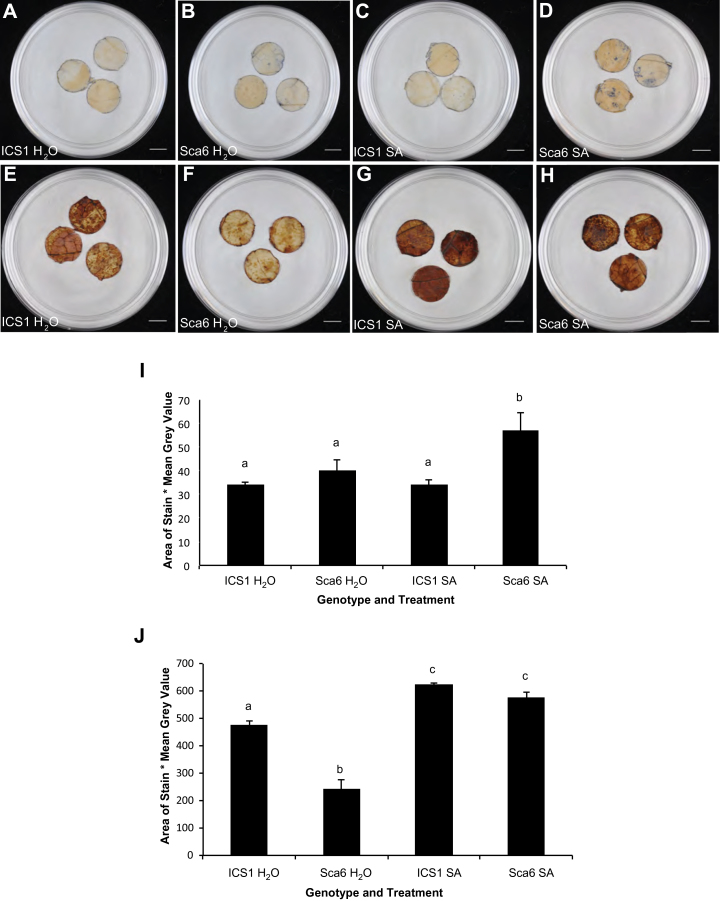
NBT and DAB staining of cacao leaf discs 24h after SA or water treatment. (A) NBT-stained ICS1 treated with water, (B) NBT-stained Sca6 treated with water, (C) NBT-stained ICS1 treated with SA, (D) NBT-stained Sca6 treated with SA, (E) DAB-stained ICS1 treated with water, (F) DAB-stained Sca6 treated with water, (G) DAB-stained ICS1 treated with SA, (H) DAB-stained Sca6 treated with SA. Scale bars, 1cm. (I) Mean product area of leaf disc stained by NBT and mean grey value of stained area for each genotype and treatment. (J) Mean product of area stained by DAB and mean grey value of stained area for each genotype and treatment. In I and J, differences between bars marked with the same letter are not statistically significant (Fisher’s PLSD analysis P>0.05), standard errors were calculated from five biological replicates, and each biological replicate is a plate containing three leaf discs.